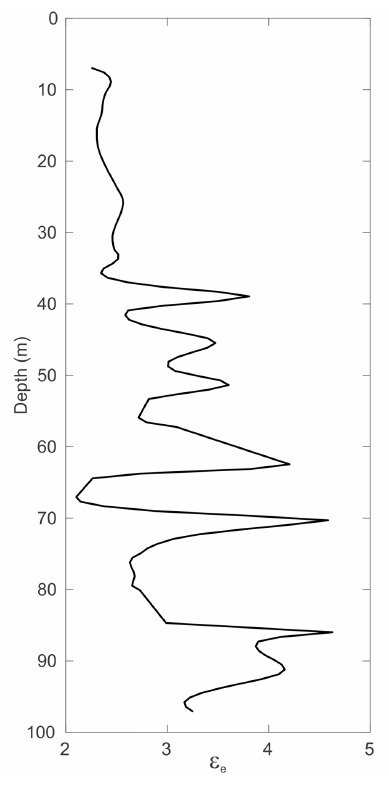
Figure 5. Permittivity estimates ε e ( z ) at their corrected